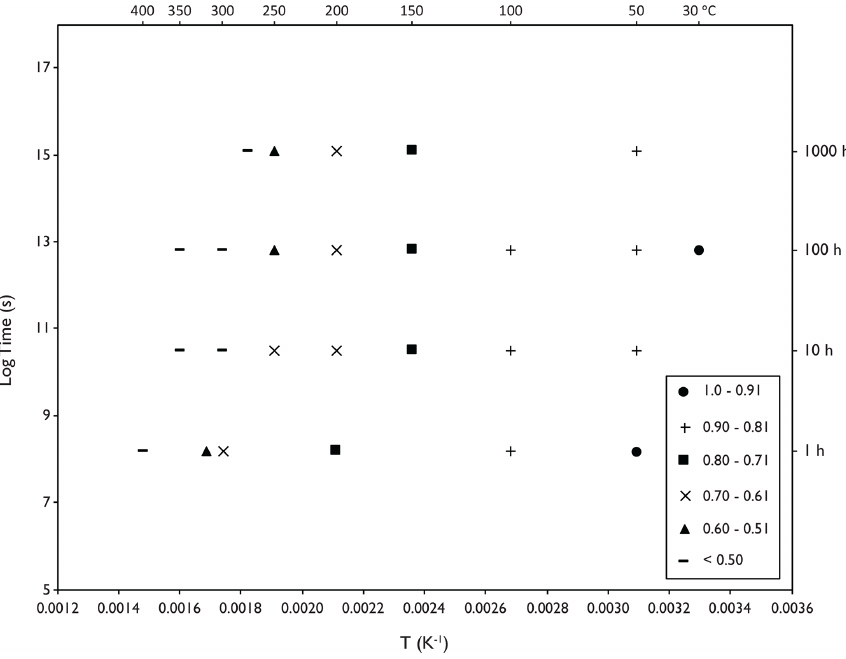
Figure 7. Arrhenius plot of experimental data using calculated equivalent confined fission track lengths in Harcourt granodiorite monazite. Each point represents two annealing experiments that have been averaged across both orientations (// and ⊥ surfaces, as in Fig. 4). Different degrees of track length reduction ( r ) are shown by different symbols. Inverse absolute temperature in Kelvin is shown on the x axis, and the corresponding temperatures in ◦ C are shown along the